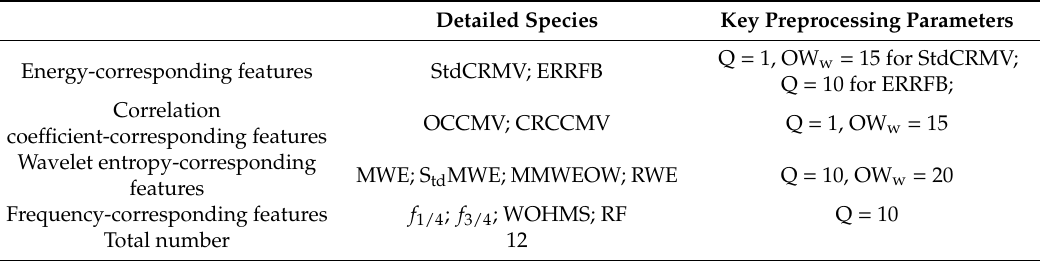
Table 3. Summary of extracted